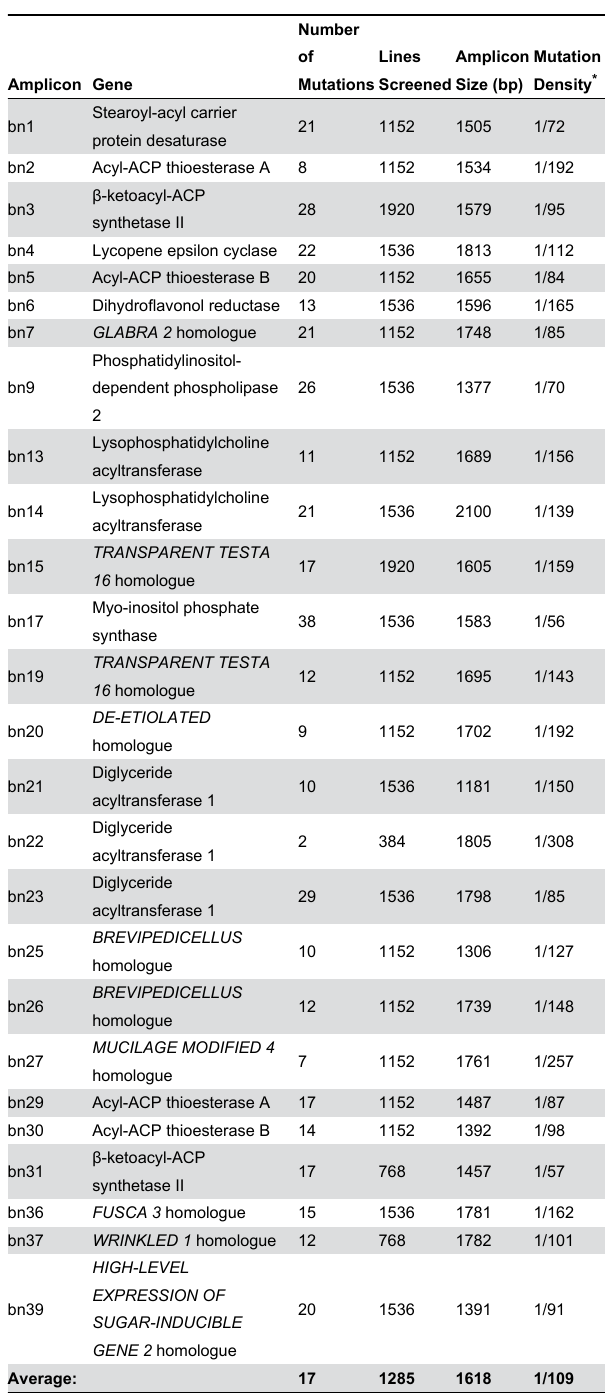
Table 2. Number of mutations identified and number of lines screened for each